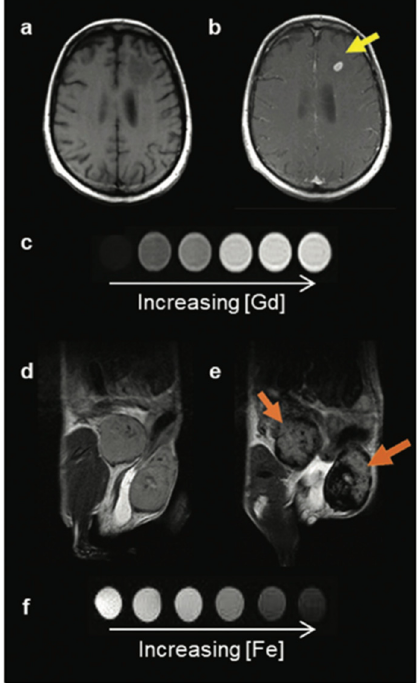
Figure 3. Two classes of MRI contrast agents. ( a ) Pre- and ( b ) post-GBCA T1-weighted MRI on a brain metastasis in a melanoma patient. ( c ) T1 contrast agents decrease the spin-lattice (T1) relaxation time, increasing signal with increasing agent concentration, and produce brighter contrast images. ( d ) Pre- and ( e ) post-IONP-based contrast agent T2-weighted MRI on inflamed mouse mammary gland tumours. ( f ) T2 contrast agents decrease the spin-spin (T2) relaxation time, decreasing signal with increased agent concentration, and produce darker contrast images. Image taken with permission from Jeon et al., 2021 [35].